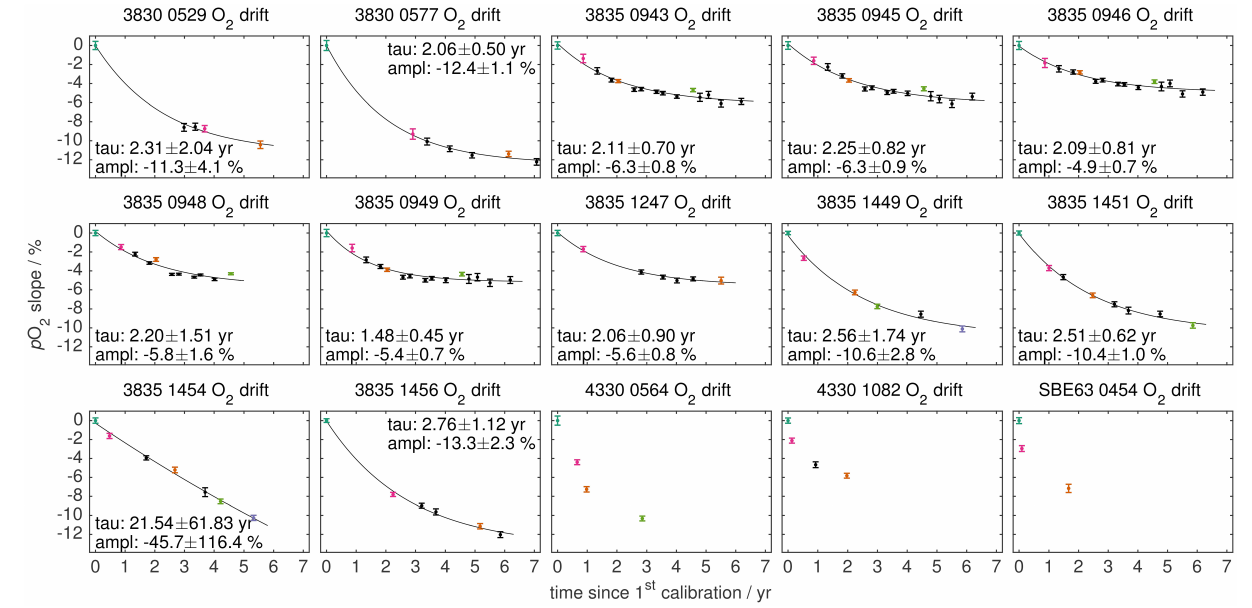
Frontiers in Marine Science |